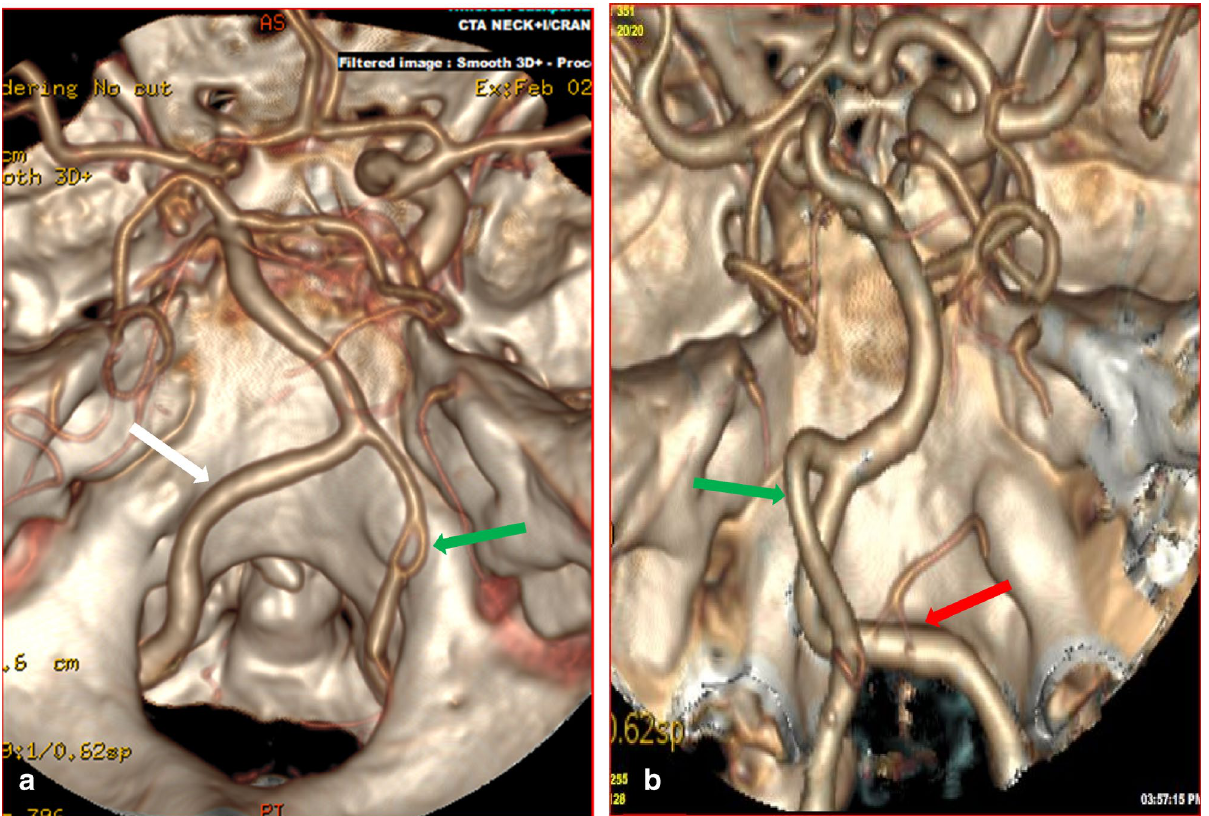
The red arrow illustrates duplicate PICA origin, while the green arrow indicates the left